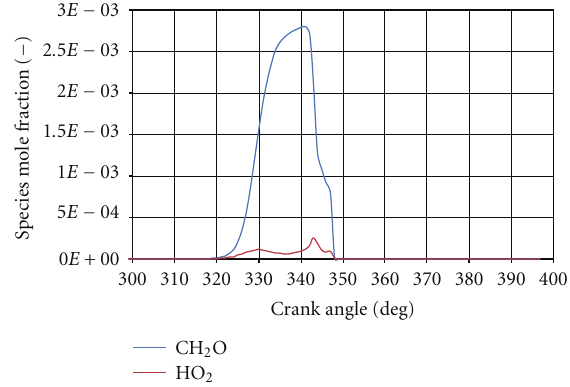
Figure 14: OH radical formation (1400rpm; 25% load; 17.5 CR; 0%